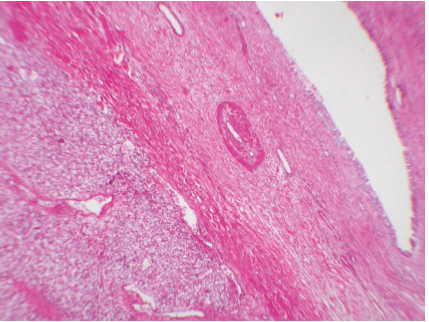
Figure 3: Renal cell carcinoma closer to the pelvic cavity observed under small magnification (H&E ×